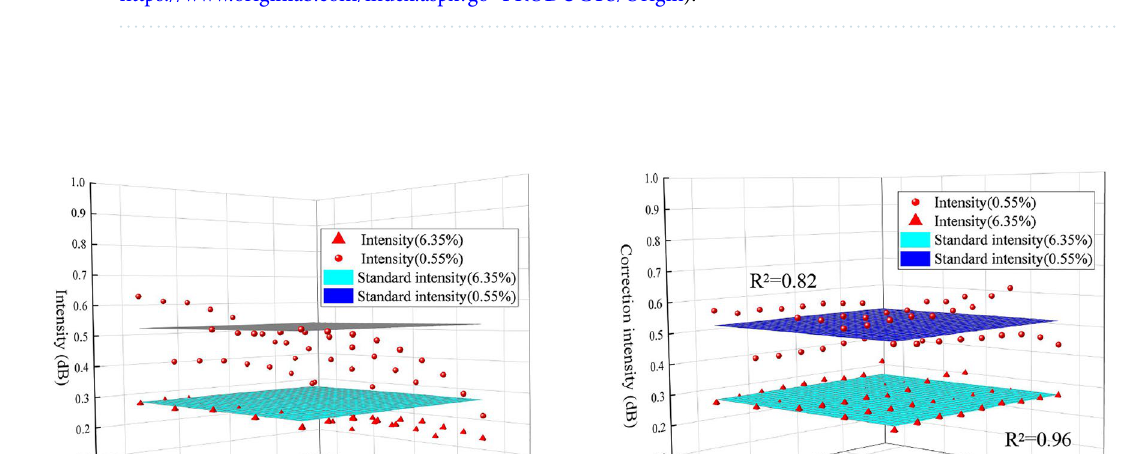
Figure 8. Intensity value before correction ( A ) and after correction ( B ) with the standard intensity of the normal incidence angle and 4 m (Software: Riscan pro 2.1; riscan-pro.software.informer.com; Origin 2021b; https:// www. origi nlab. com/ index. aspx? go= PRODU CTS/ Origin).